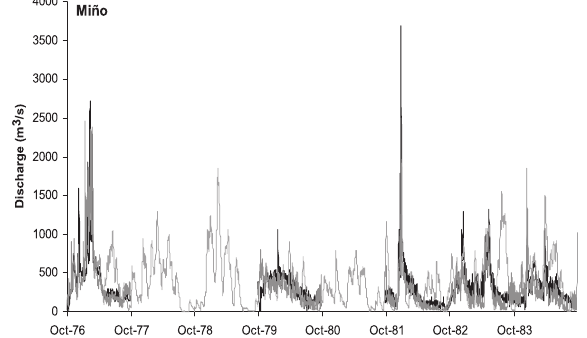
Fig . 6. – Mean daily discharge at the mouth of the River Miño di- rectly estimated from gauge records at Foz do Mouro station (black line), estimated from runoff observed in the River Douro (thick gray line) and from precipitation (thin gray